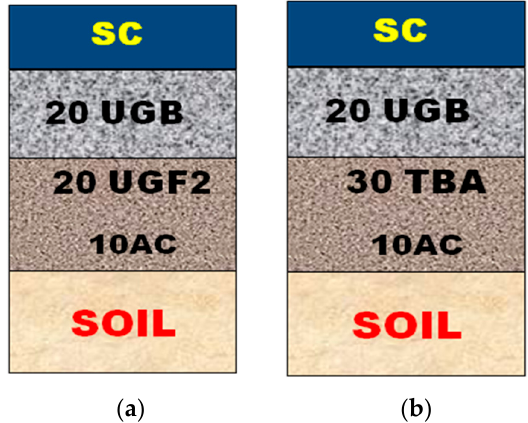
Figure 6. ( a ) Conventional pavement structure, ( b ) Pavement structure based on